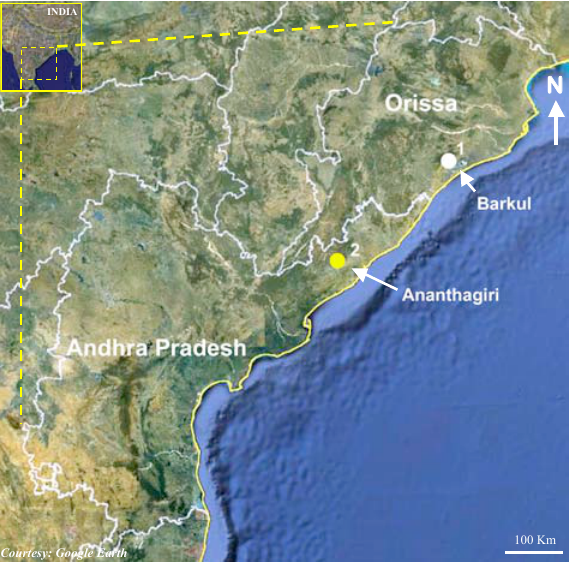
Figure1: Satellite image showing a map depicting records of Sipalolasma arthrapophysis ( 1915) in two Indian states. Gravely